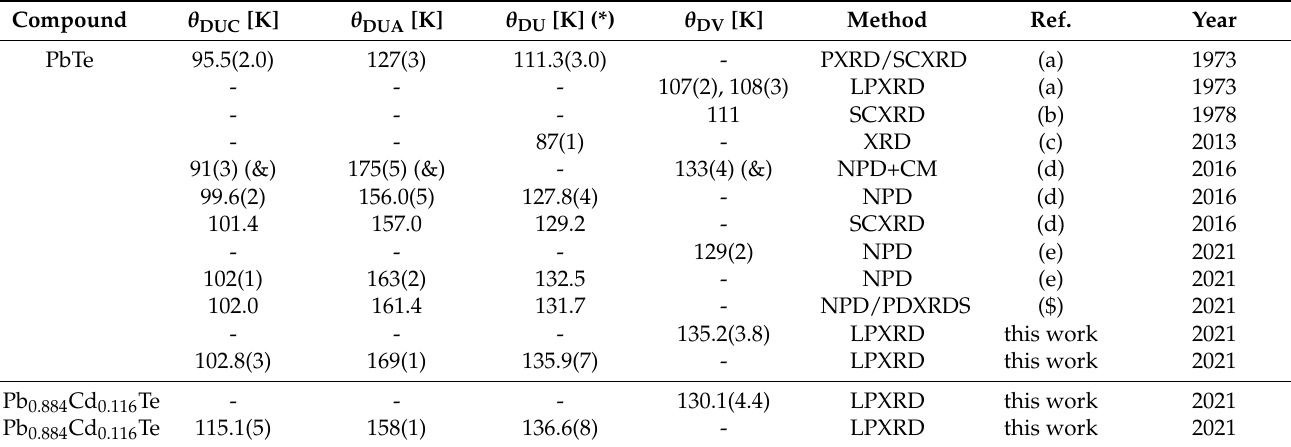
Table 11. Values of experimental Debye temperature θ D determined by XRD/ND for PbTe and Pb 1 − x Cd x Te ( x = 0.116) and earlier reported experimental values for PbTe: data θ DUC and θ DUA refer to values determined for cationic and anionic sublattices, respectively.